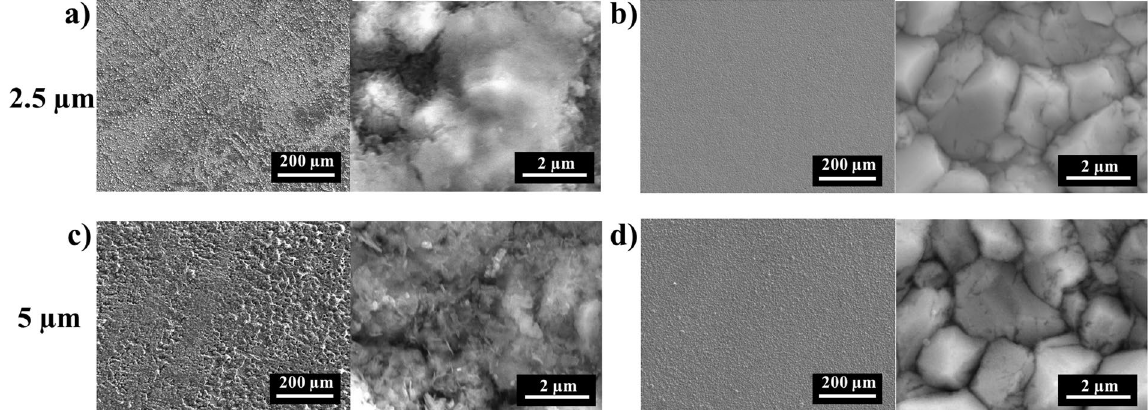
Figure 1. Electrochemical deposition of 2.5 μ m thick Mn film on ( a ) as-received, and ( b ) polished W and 5 μ m thick Mn film on ( c ) as-received, and ( d ) polished W substrates.